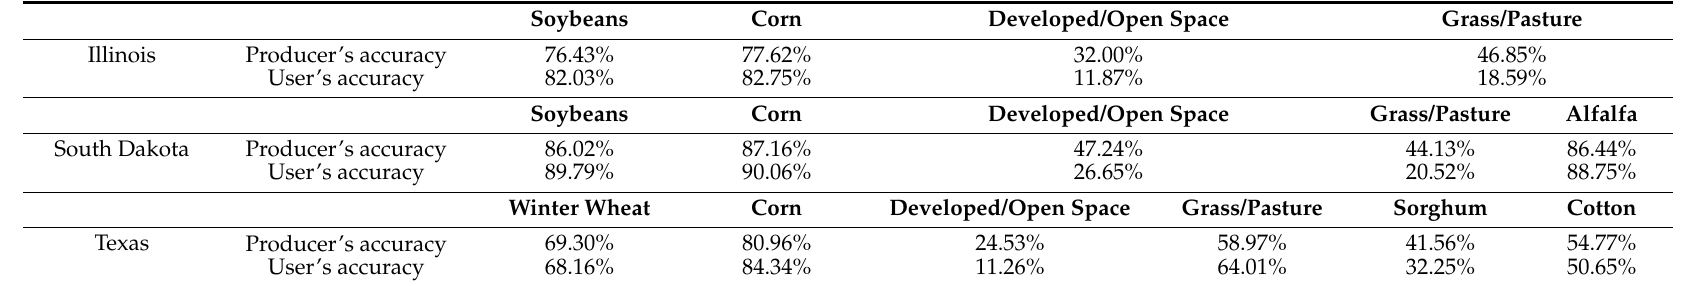
Table 5. Mean producer and user accuracies of classification based on PCA + RF